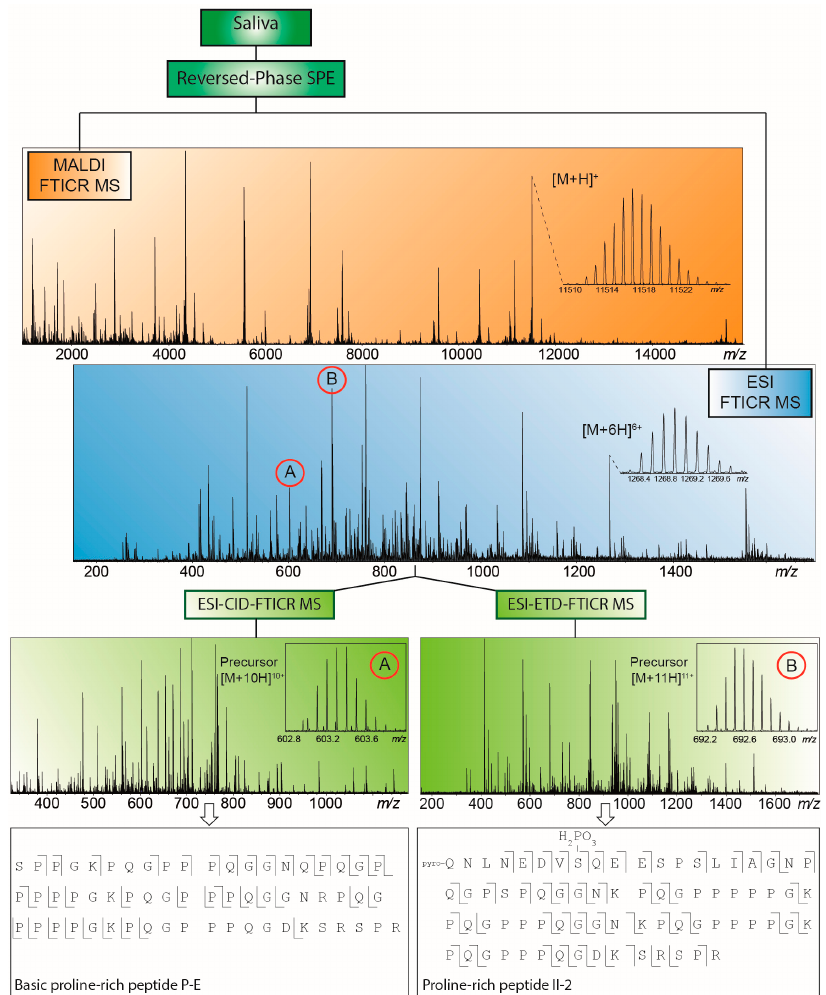
Figure 2. MALDI-FTICR (in orange) and electrospray ionization (ESI)-FTICR (in blue) saliva peptide and protein profiles obtained after RPC18-based cleanup. Multiply charged species in the ESI-FTICR profile (indicated with A and B) were selected for tandem mass spectrometry (MS/MS) analysis, with identification results shown at the bottom (in green).